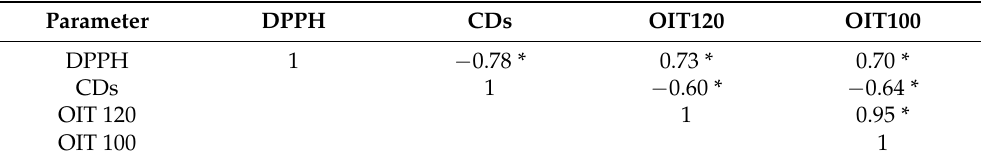
Table 1. Pearson’s r coefficients calculated for the correlation between the antioxidant activity (DPPH), diene concentration (CDs) and oxidation induction time (OIT) of the wafer samples.